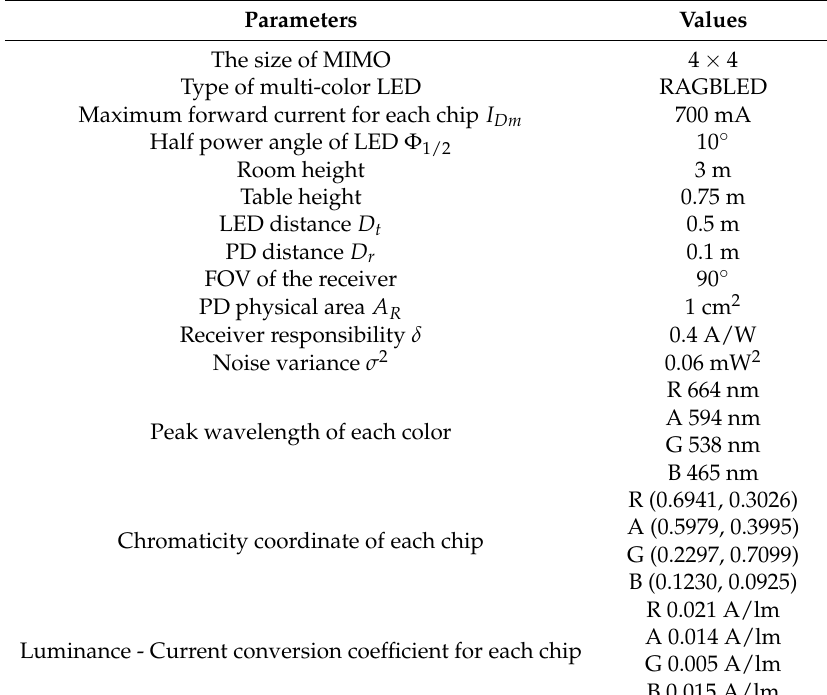
Table 1. Simulation parameters used in the MIMO VLC system.